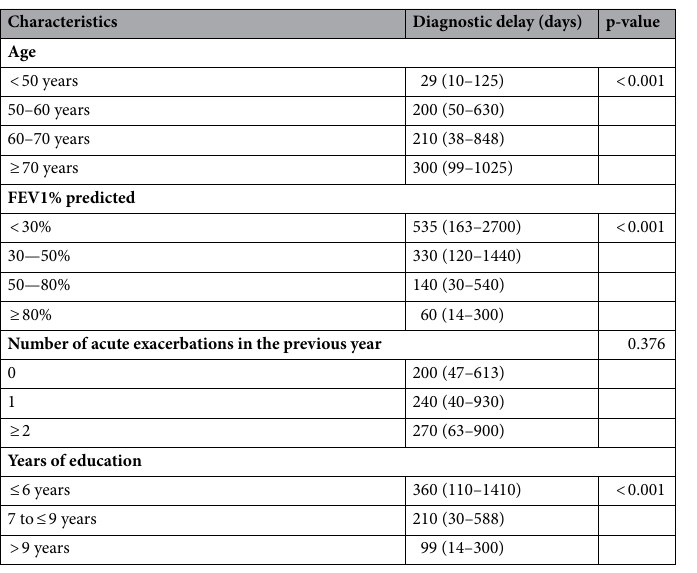
Table 4. Kruskal–Wallis H analysis for demographic differences in diagnostic delay. FEV1 forced expiratory volume in one second.